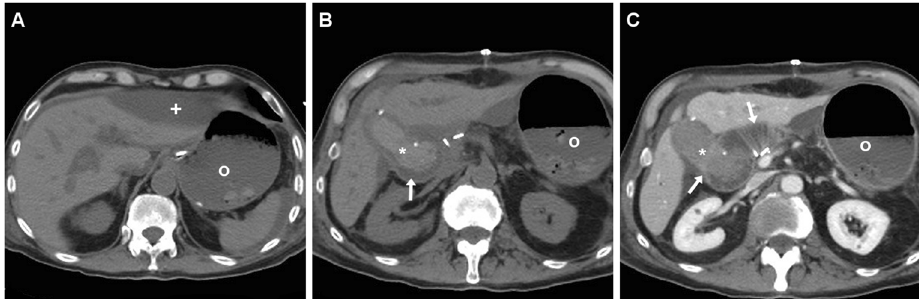
Fig. 9 Biloma and intraluminal haemorrhage in a 72-year-old man after pylorus-preservingPDfor CBDcholangiocarcinoma and initial diagnosis of postoperative PF treated conservatively. On postoperative day 16, precontrast ( a ) and contrast-enhanced ( b , c ) CT showed fluid- attenuation collection (+) located ventrally and inferiorly to the left liver